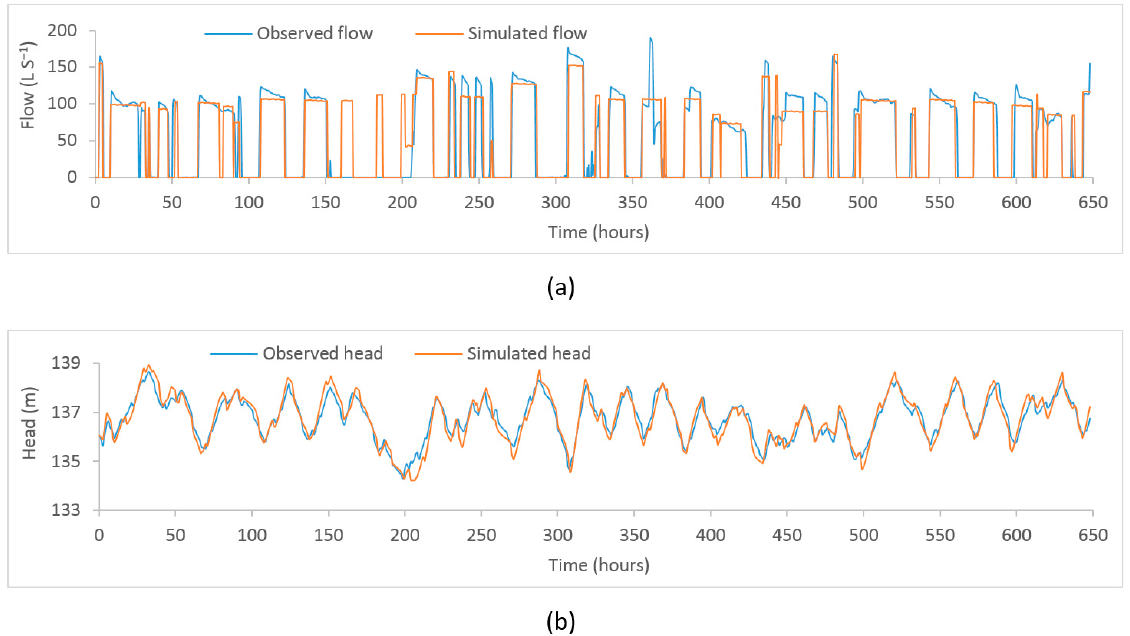
Figure A2. Plot of observed and model ‒ simulated time ‒ series. ( a ) Flow at PS2 ( b ) head at Binnies tank.